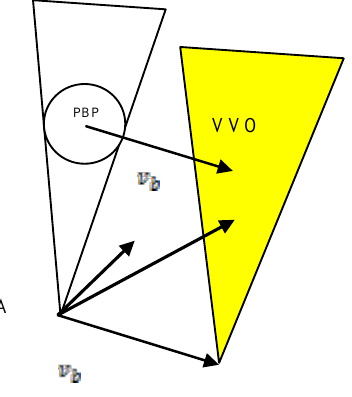
Figure 5 . Visibility Velocity